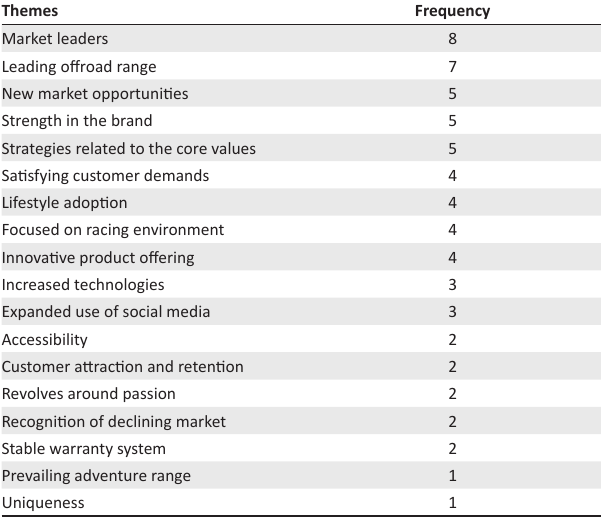
TABLE 1: Emerging themes of strategic